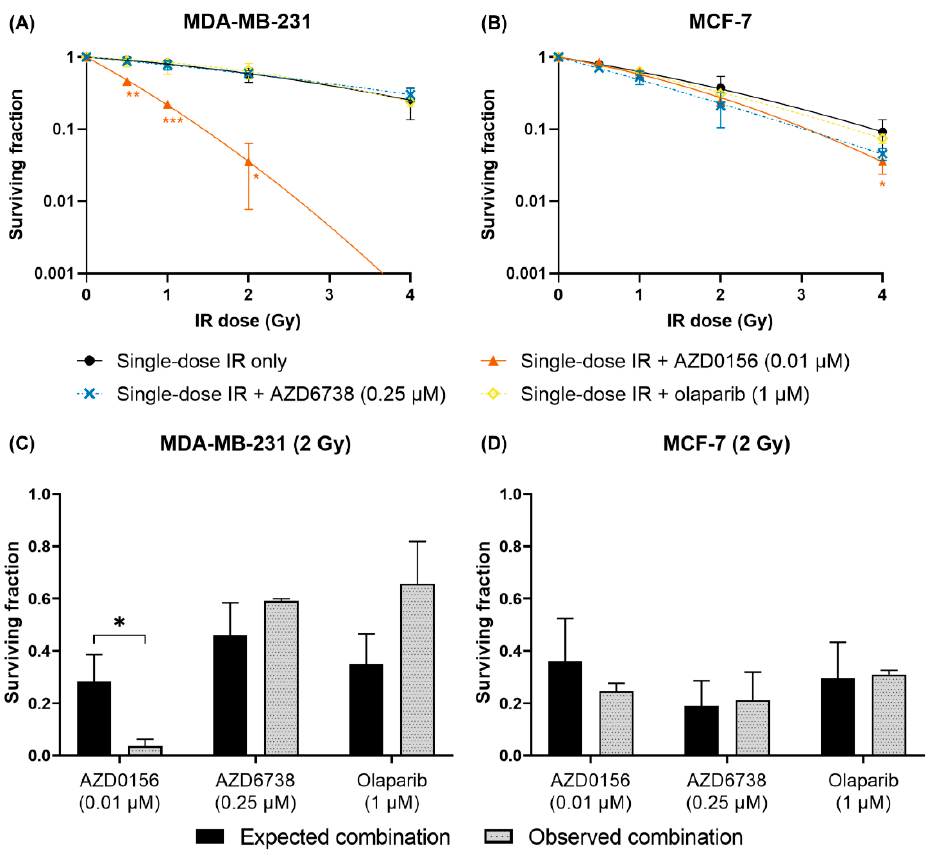
Figure 5. AZD0156 potentiates single-dose IR in MDA-MB-231 cells. ( A ) MDA-MB-231 and ( B ) MCF-7 cells were treated with AZD0156 (0.01 µM), AZD6738 (0.25 µM) or olaparib (1 µM) one hour prior to single-dose irradiation at 0.5 to 4 Gy, then cell survival was quantified with clonogenic assays. Survival curves of cells treated with single-dose IR only from previous experiments were displayed for comparison. To determine potential synergy between IR and DDR inhibition, surviving fractions of drugged ( C ) MDA-MB-231 and ( D ) MCF-7 cells irradiated at 2 Gy were compared. The expected surviving fractions from combination treatments were calculated as products of the observed surviving fractions after treatment with single-dose IR only and DDR inhibitor only. Data are shown as mean ± SD of three independent experiments performed in duplicate or triplicate wells. In ( A , B ), * p < 0.05, ** p < 0.01, *** p < 0.001 vs. single-dose IR only. In ( C ), * p < 0.05.